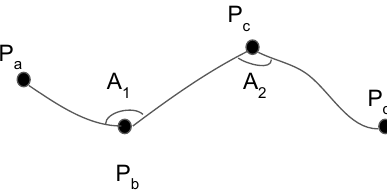
Figure 10. Heading-based